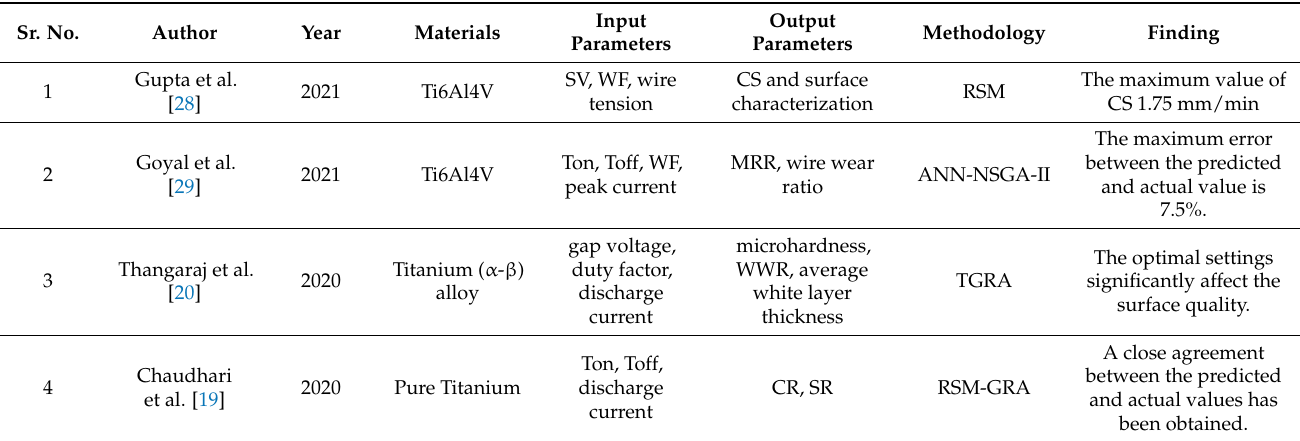
Table 1. Recent research conducted on titanium